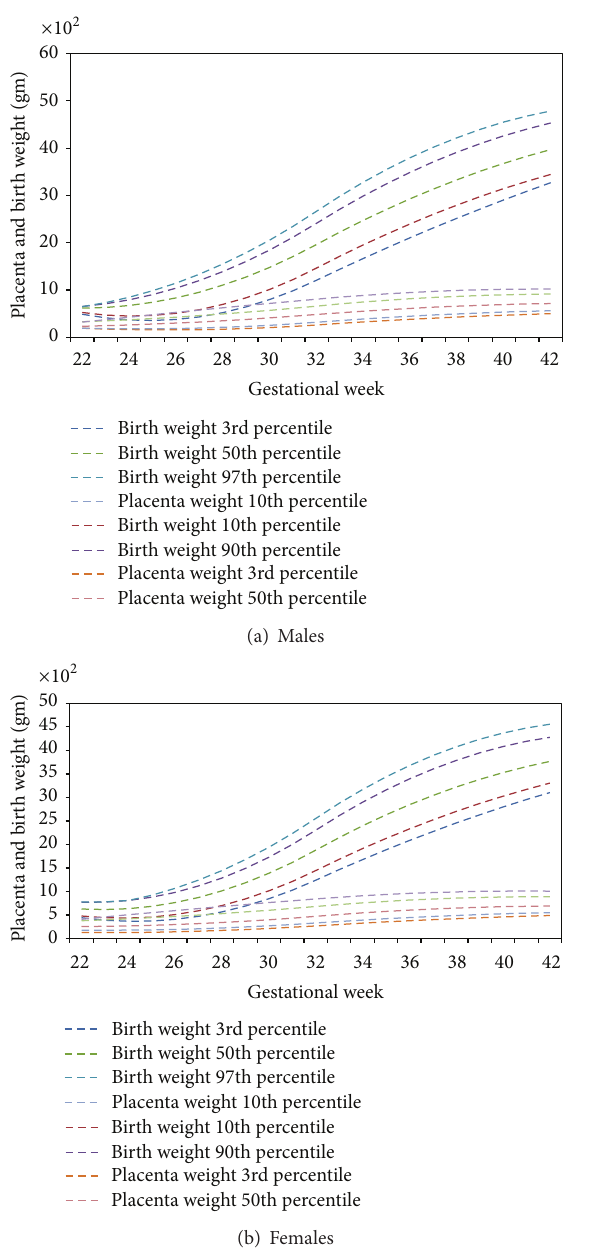
Figure 2: Inclusive of regional referrals placenta and birth weight percentile distributions by gestational age.